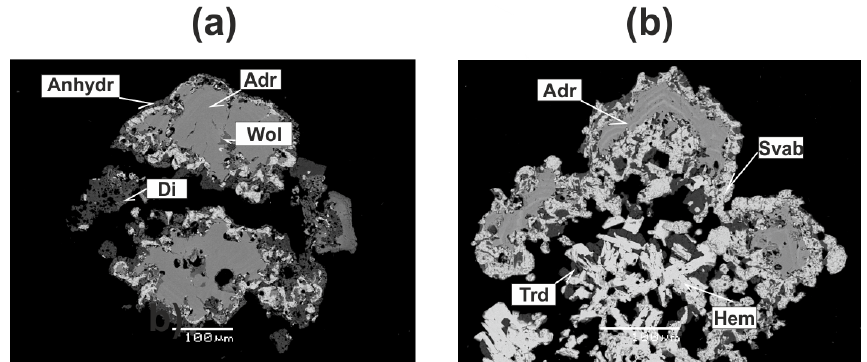
Figure 4. Zonal crystals and crusts of andradite (Adr) in association with diopside (Di), anhydrite (Anhydr), svabite (Svab), hematite (Hem), wollastonite (Wol) and tridymite (Trd). BSE images.